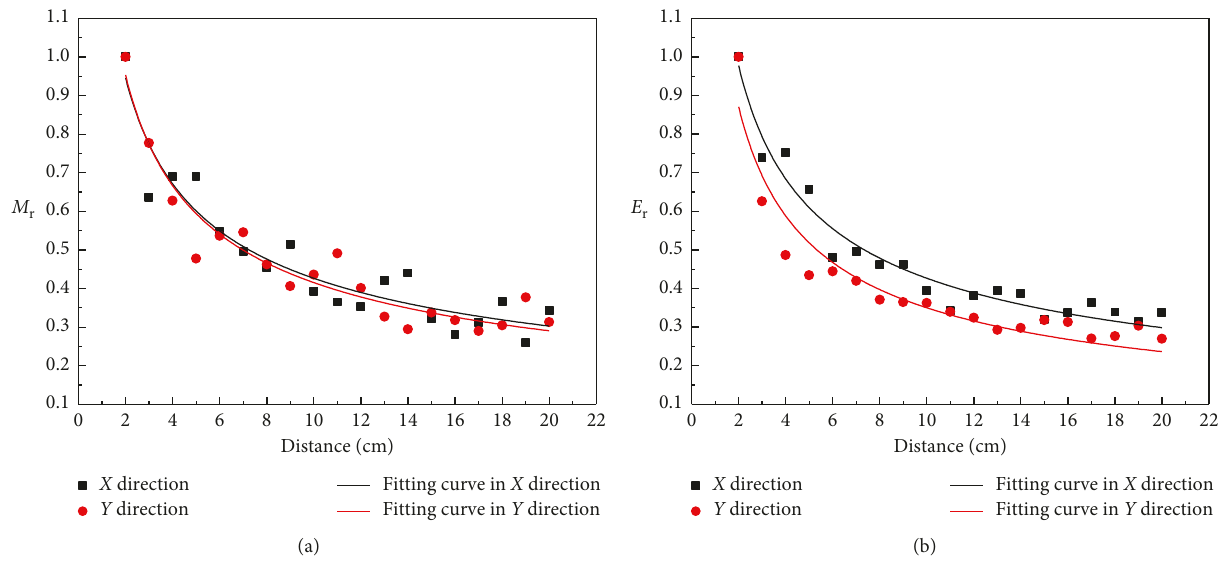
Figure 30: Relationship curves between SRS and distance. (a) Maximum coefficient. (b) Mean coefficient. Table 5: Fitting coefficient of M r and distance. Direction